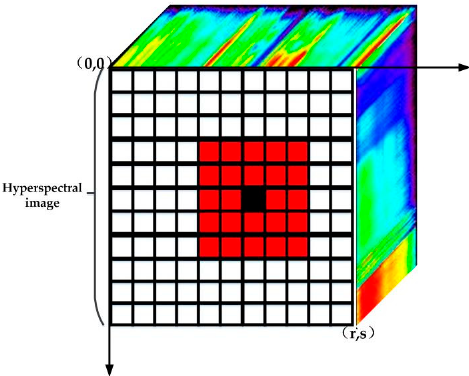
Figure 3. Diagram of the local window of hyperspectral image.